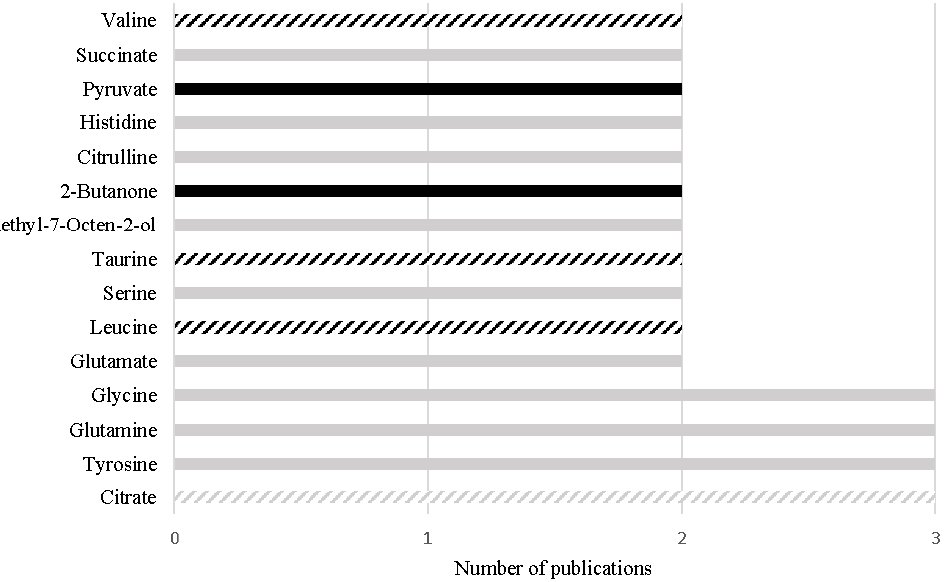
Figure 3. Metabolites found with the same alteration in urine metabolome of PCa patients in more than one study, in the last 5 years. The black bars represent metabolites increased in PCa and the grey bars represent metabolites decreased in PCa. The listed bars correspond to the metabolites that were previously found with the same variation in PCa tissue.